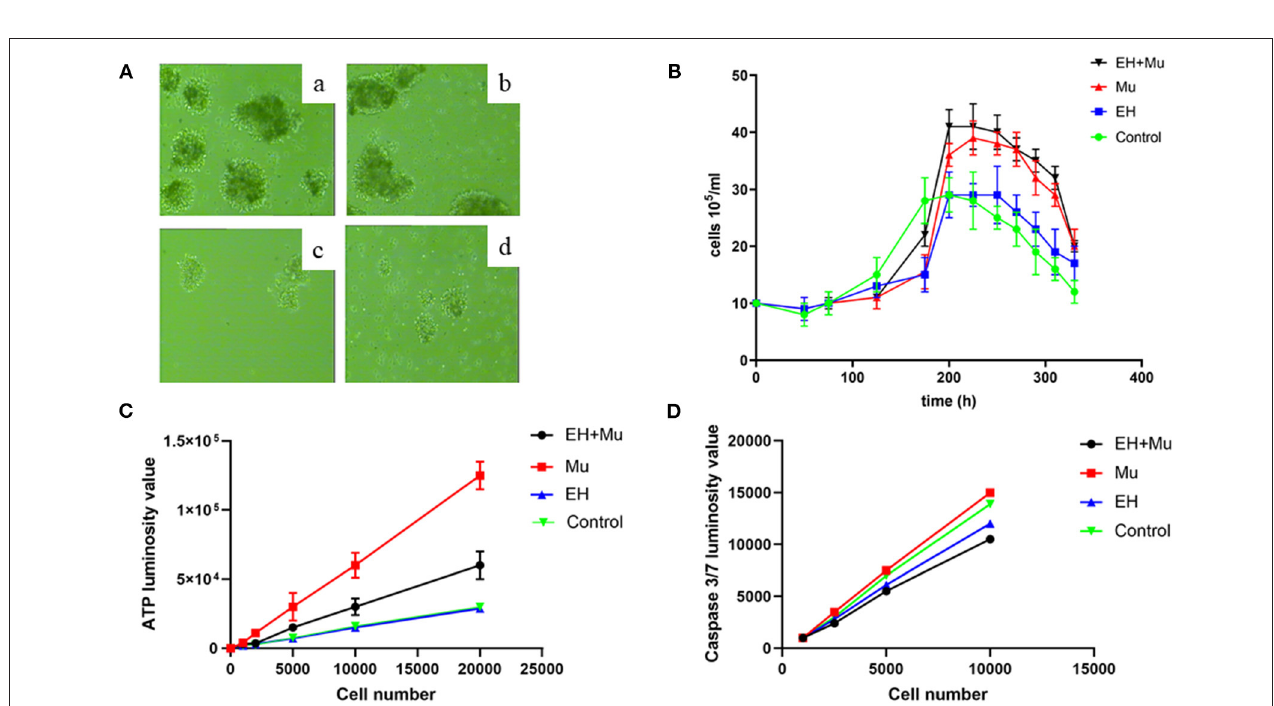
FIGURE 4 | Plasma APN and expression of APN-related molecules. (A) The plasma APN levels of patients with or without tRNA 15910 C > T and/or EH (* P < 0.05 vs. Mu group; # P < 0.05 vs. EH group; 1 P < 0.05 vs. control group); (B) The mRNA levels of APN-related molecules in each group. (* P < 0.05 vs. Mu group; # P < 0.05 vs. EH group; 1 P < 0.05 vs. control